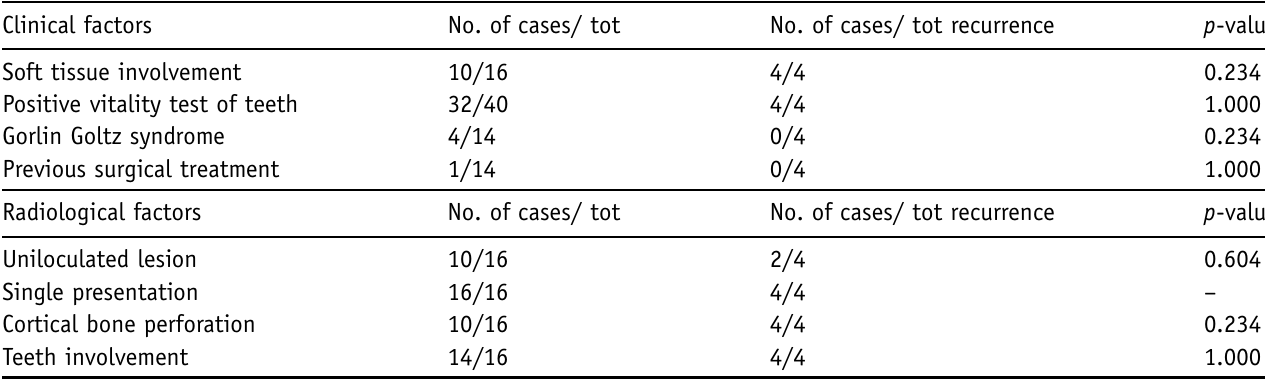
Table II. Clinical and radiological factors affecting recurrence.